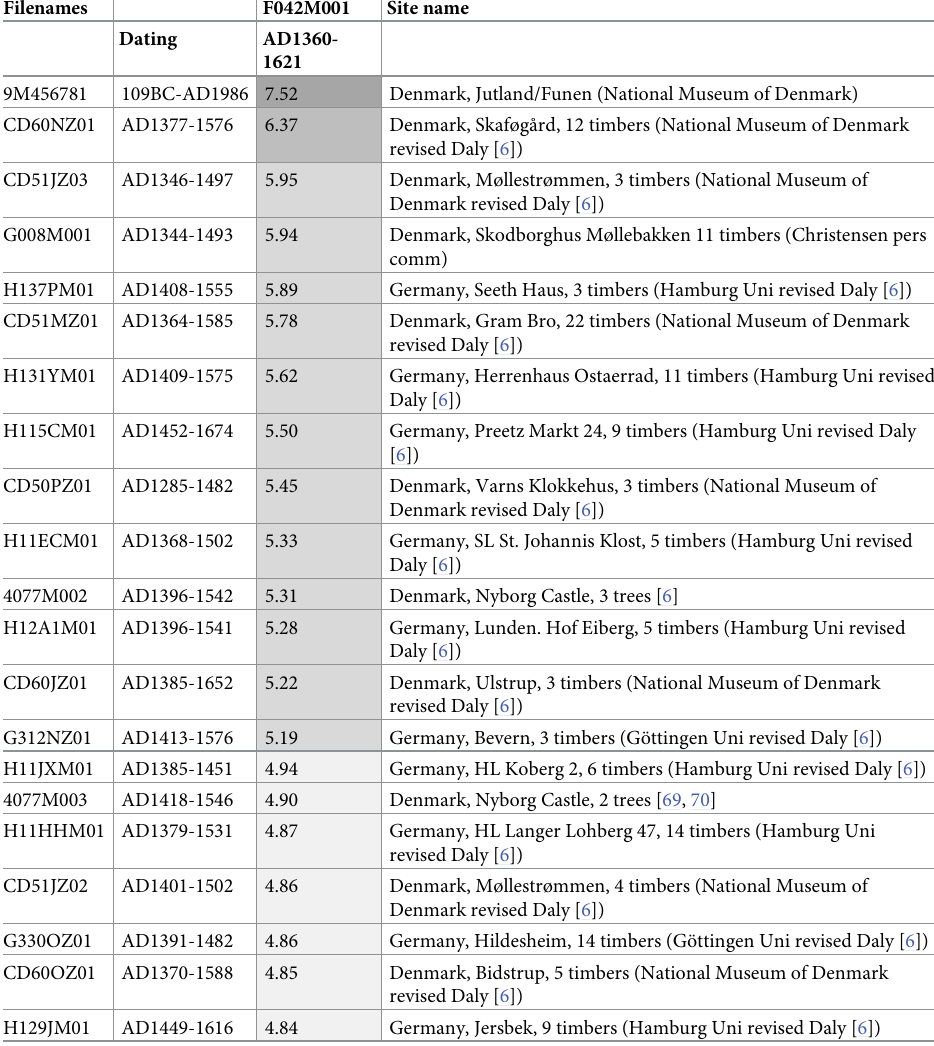
Table 5. Correlation ( t -value Baillie & Pilcher [57]) between the Horsens timber group in this study that dendrochronologically indicates a Danish provenance.